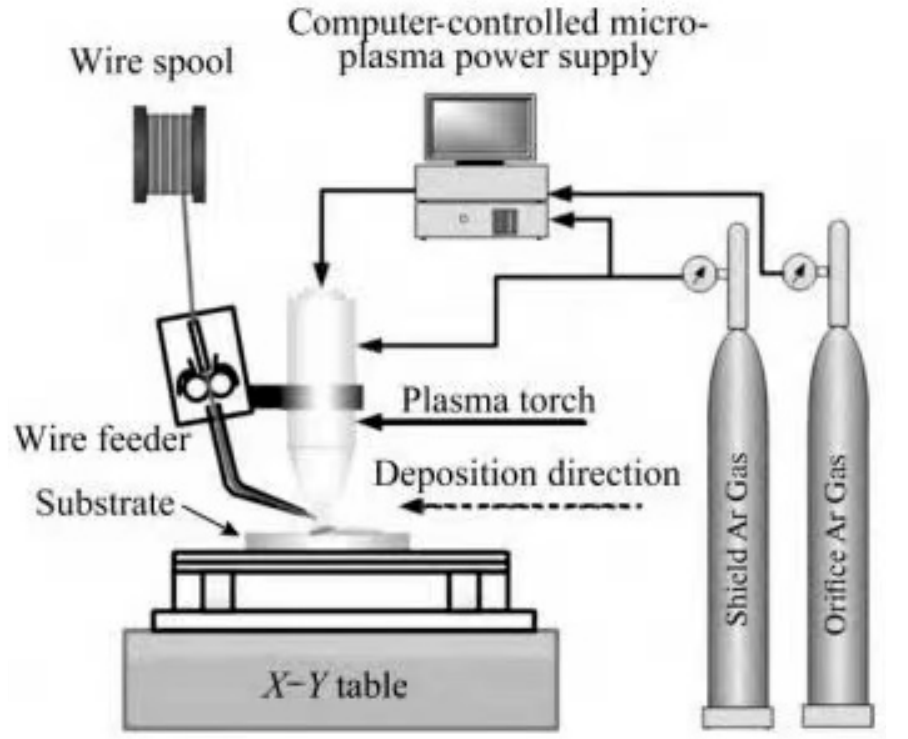
Figure 7. Schematic diagram of wire arc additive manufacturing equipment [82]. Reprinted from J. Manuf. Process., 35, Wu, B.; Pan, Z.; Ding, D.; Cuiuri, D.; Li, H.; Xu, J.; Norrish, J, A Review of the Wire Arc Additive Manufacturing of Metals: Properties, Defects and Quality Improvement, 127– 139, 2018, with permission from Elsevier.